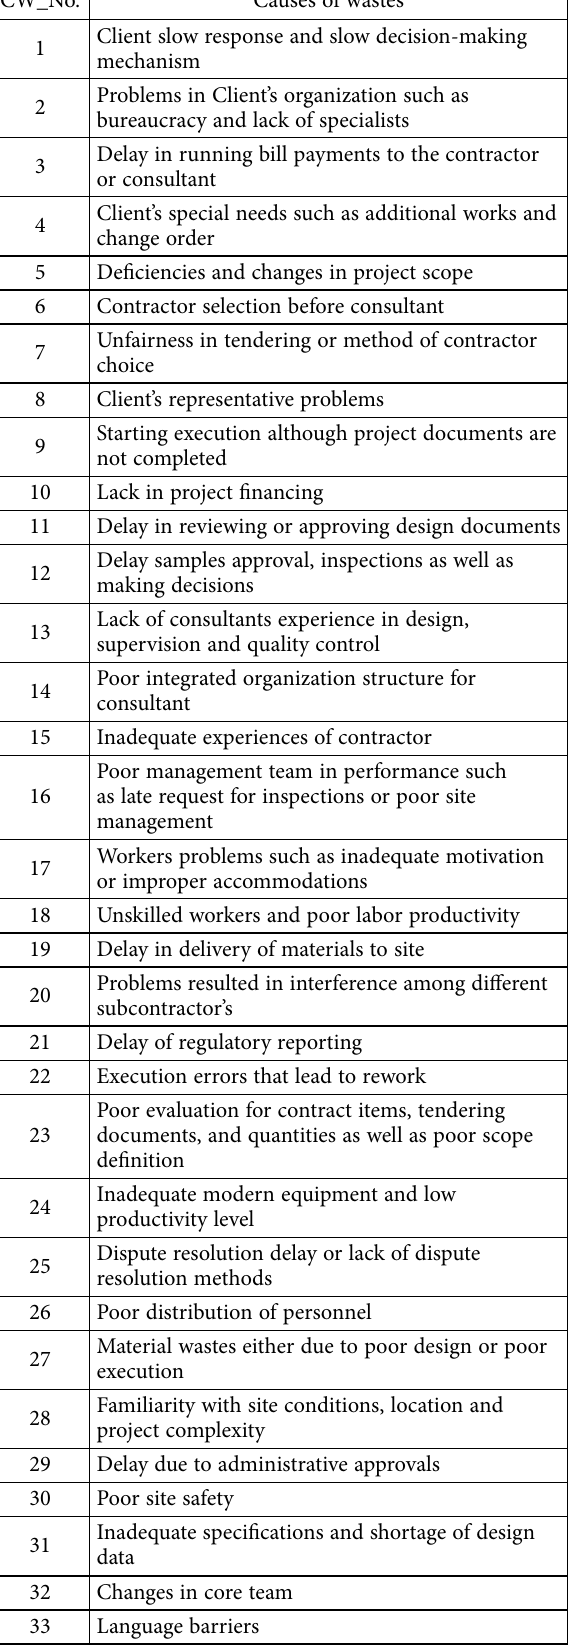
Table 5. The identified CWs (Issa & Salama, 2018) Causes of wastesCW_No.